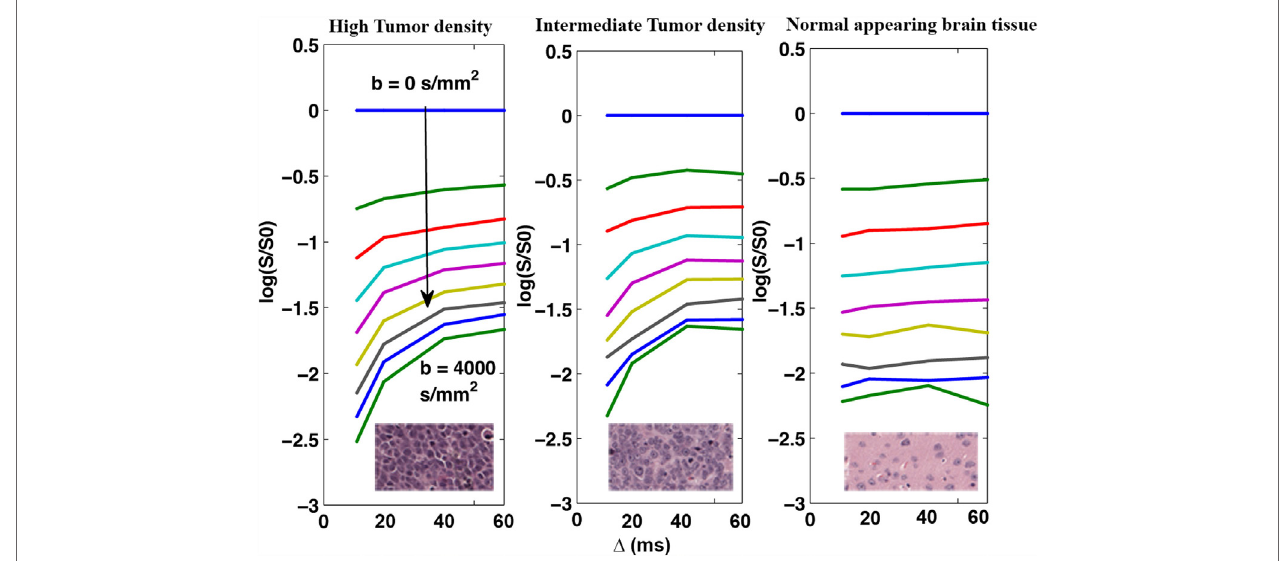
FigUre 2 | Mean DW-signal as a function of Δ for the three tissue regions averaged across the two Mri slices . The DW-signal (plotted on log scale) from both the primary tumor site with high cell density (left) and the intermediate region with intermediate cell density (middle) demonstrate strong dependence on Δ , with 140% increase in signal intensity over the range of 10–60